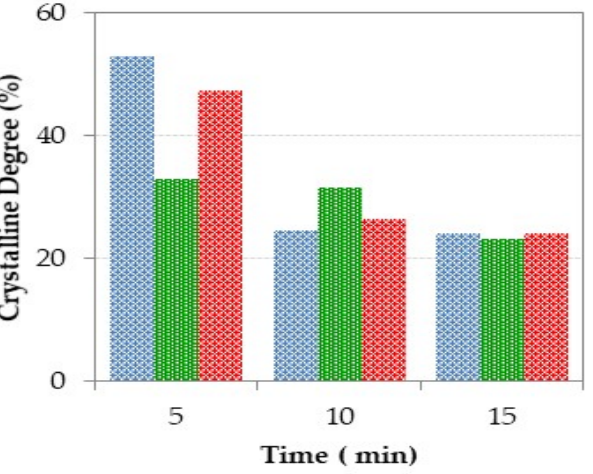
Figure 9. Percentage of crystallinity of the glasses prepared using CSE for different radiation exposure time (blue: M x -ES, green: M x -MS and, red: M x -DO).